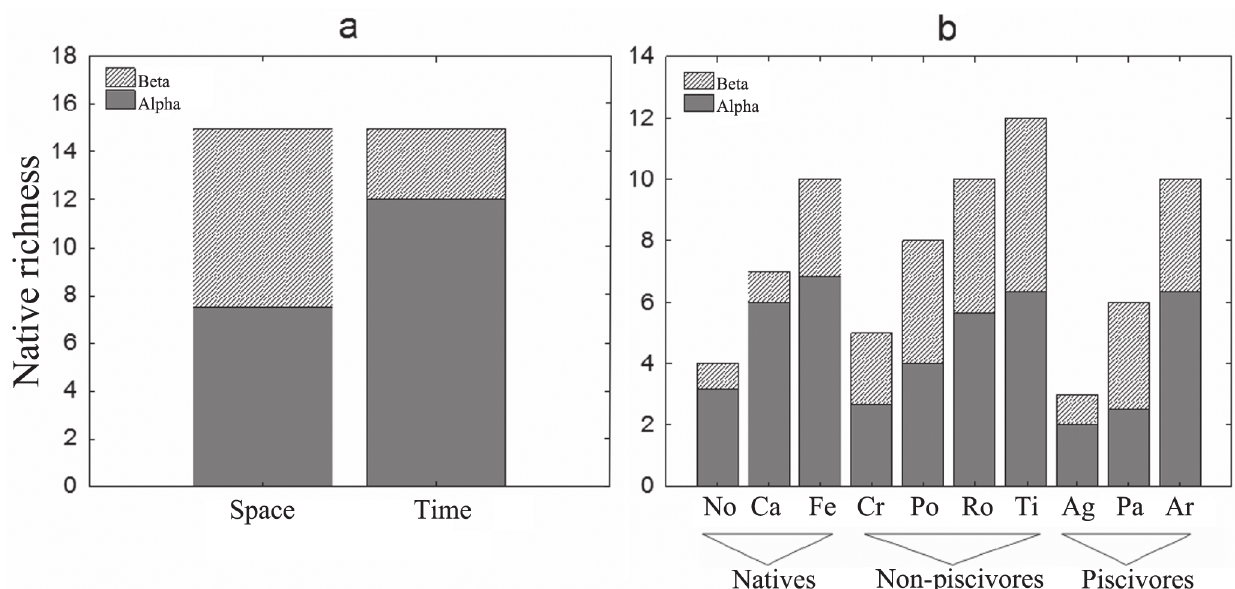
Fig. 2. Alpha (mean) and beta richness. a ) Comparison among the temporal and spatial components of richness. b ) Species richness for each lake. The alpha (mean) and beta richness were taken along the temporal component. Lake codes: No = Nova; Ca = Capim; Fe = Ferrugem; Cr = Crentes; Po = Poço Redondo; Ro = Romoalda; Ti = Timburé; Ag = Águas Claras; Pa = Palmeirinha; Ar = Ariranha. “Natives” represents lakes without non-native species; “Non-piscivores” represents lakes with non-piscivorous non-native species; “Piscivores” represents lakes with invasive piscivorous